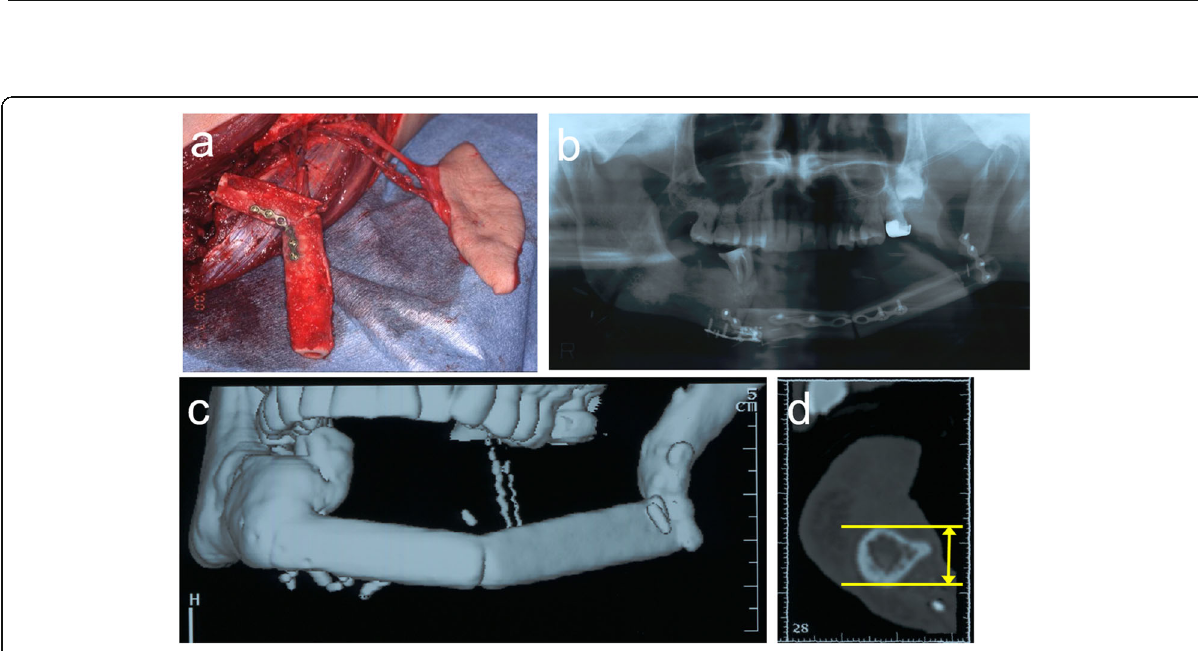
Fig. 3 a A free vascularized fibula flap. b Orthopantomogram after mandibular reconstruction with a free vascularized fibula flap. c 3-D computed tomography scan and d cross sectional image 1 year after the mandibular reconstruction with a free vascularized fibula flap. The height of the fibula was 12